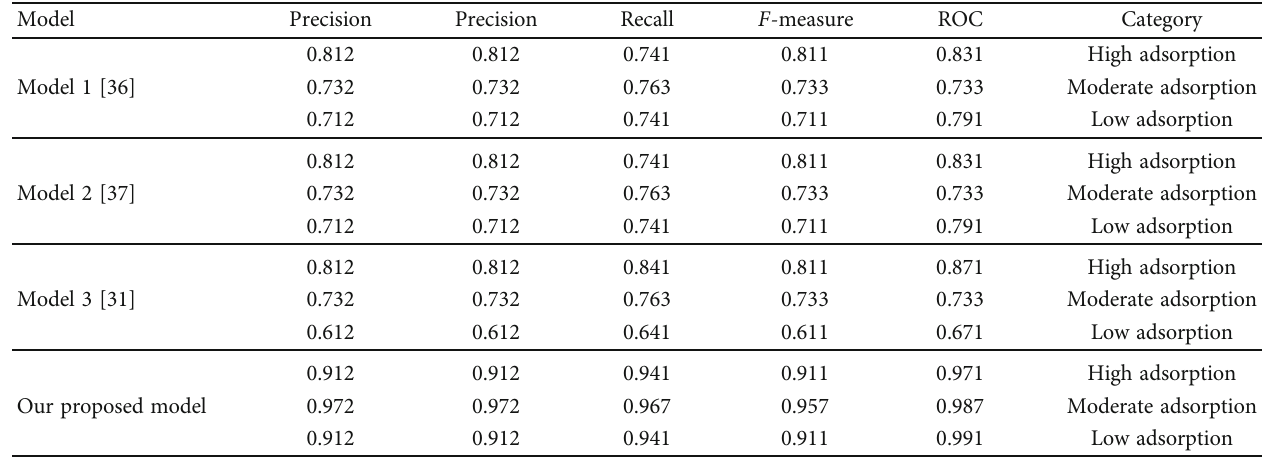
Table 8: Confusion matrix for the accuracy, speci fi city, and sensitivity for the compared adsorption prediction models for three adsorption states (high, moderate, and low) for temperature 25 ° C and pressure of 1 bar.